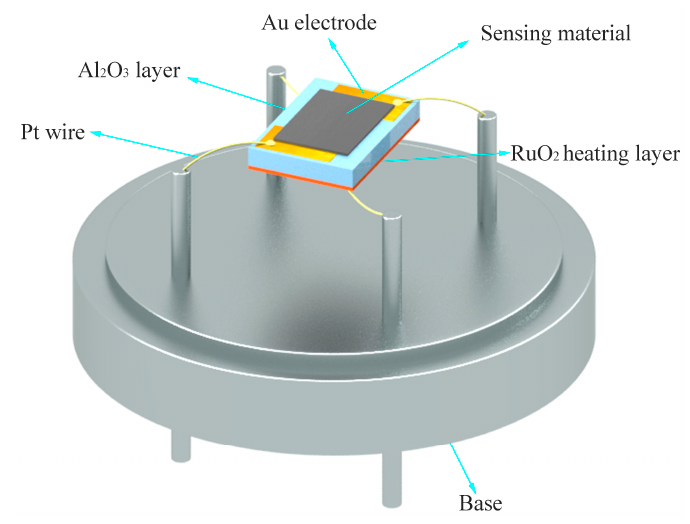
Figure 1. Schematic diagram of the packaged gas sensor.